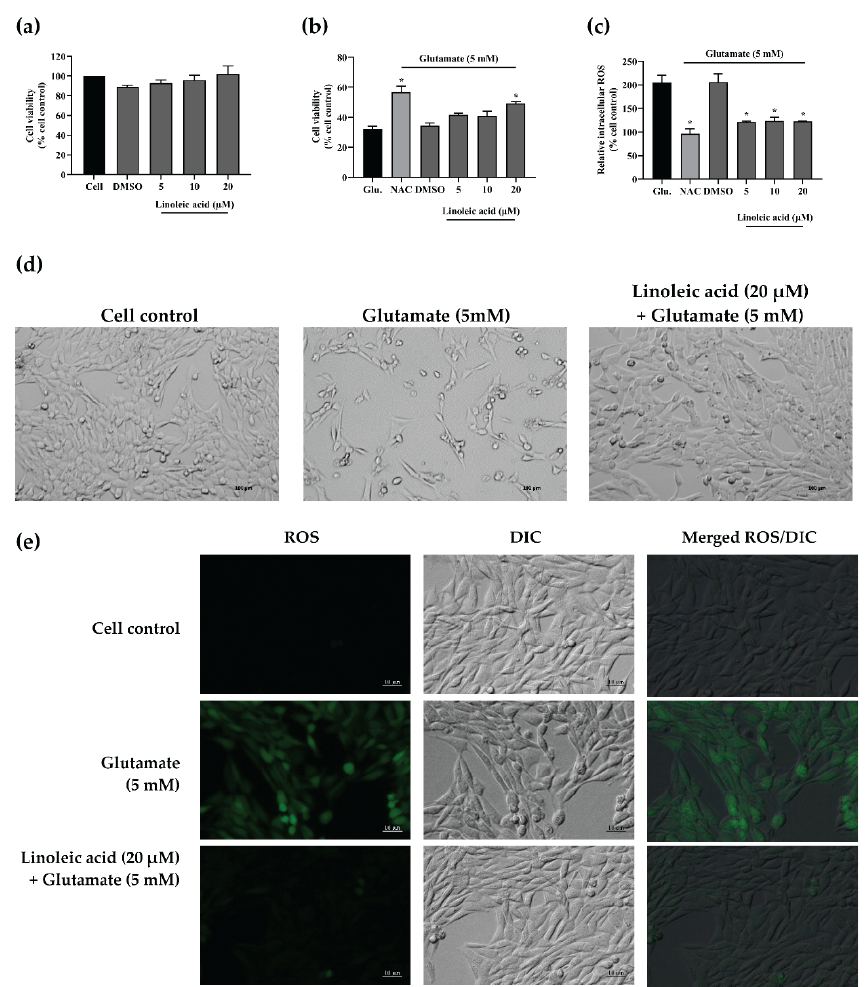
Figure 10. Neuroprotective effects of linoleic acid on glutamate-induced HT-22 cell toxicity. ( a ) Cytotoxicity of linoleic acid on HT-22 cells. ( b ) The effect of linoleic acid on glutamate-induced HT-22 cell death. ( c ) Quantitative analysis of intracellular ROS inhibitory activity of linoleic acid on glutamate-induced HT-22 toxicity. N -acetyl cysteine (NAC, 0.5 mM) and DMSO (0.1%, v / v ) were used as the positive and vehicle control, respectively. All data are shown as the mean ± SEM of triplicate values. Statistical significance was analyzed by one-way ANOVA, Dunnett test. * p < 0.05 versus the glutamate (Glu.) control. ( d ) Morphological changes of glutamate-induced HT-22 hippocampal cells after co-treatment with linoleic acid (20 µM) for 12 h. ( e ) Qualitative analysis of intracellular ROS in glutamate-induced HT-22 cells observed under fluo- rescence and differential interference contrast (DIC) microscopes at 10× magnification. The scale bar indicates 10 µm.